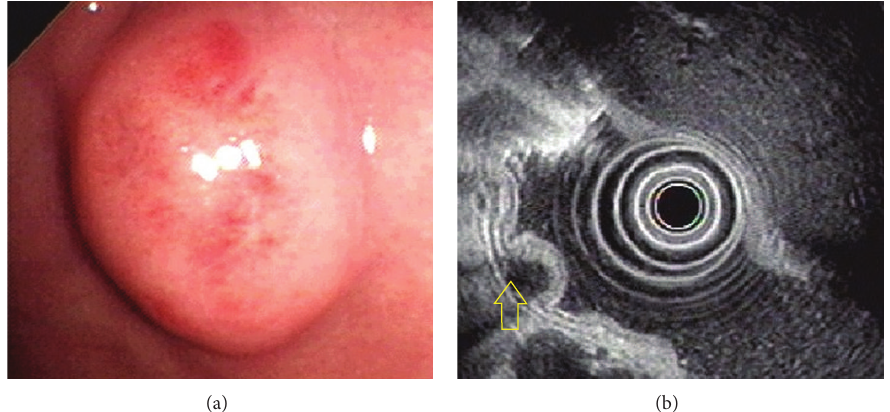
Figure 4: Ectopic pancreas originates from the fourth sonographic layers of the gastric wall. (a) A subepithelial tumor with intact mucosa was identified at antrum. (b) Endoscopic ultrasonographic image obtained with a 12 MHz catheter probe. The tumor exhibits homogenous, hypoechoic echogenicity and distinct margin originating from the fourth sonographic layer of gastric wall